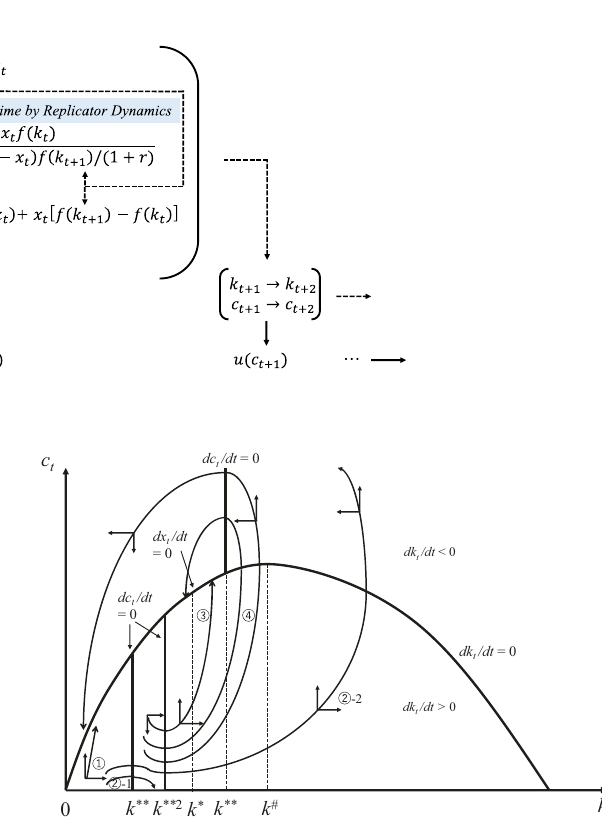
Fig. 4 Budget-controlled growth path in the case of k # < k ** _ k t < 0